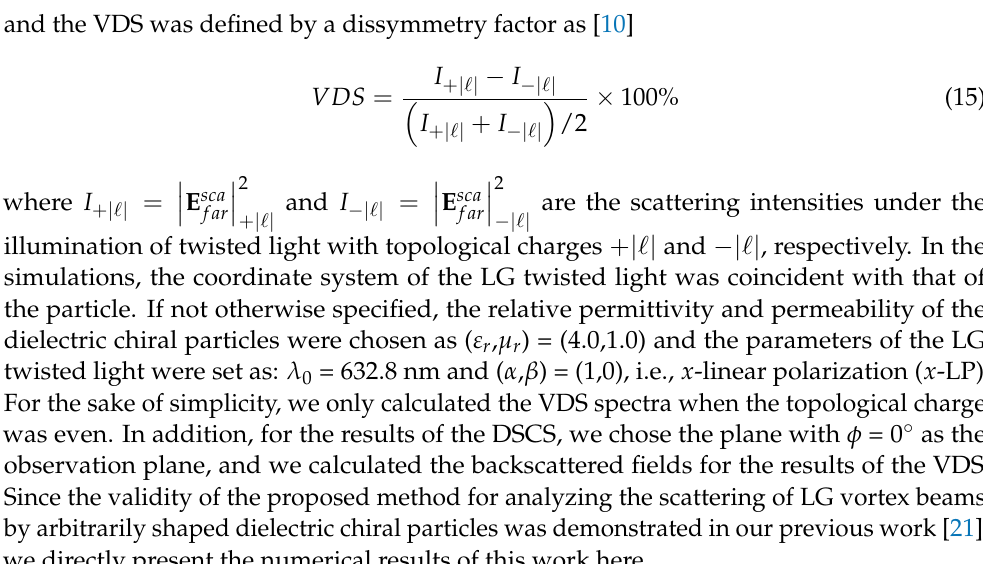
±  . ( b ) DSCSs at scattering angle o =180 θ  from 0 to